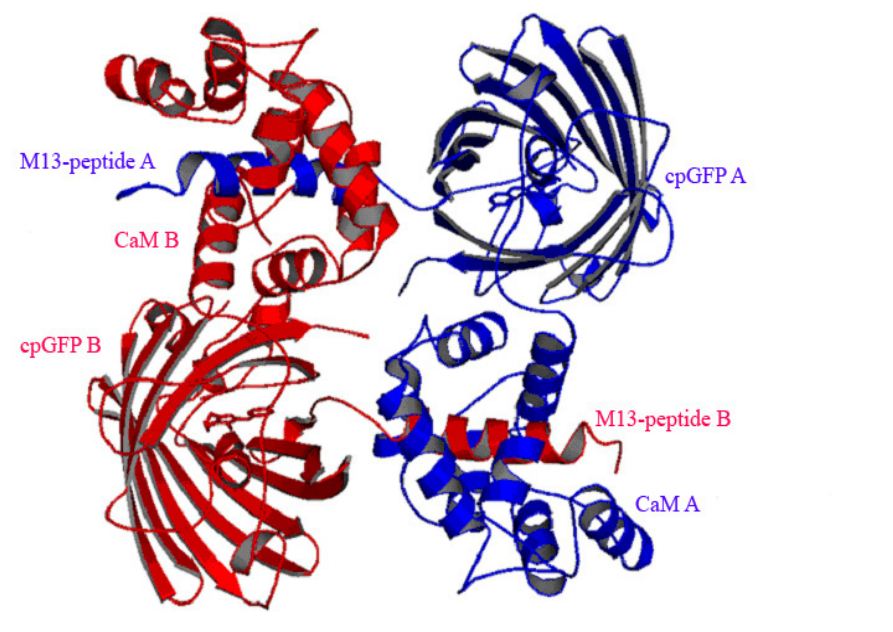
Figure 3. Ribbon diagram of Case12 structure B. Two Case12 (chains A and B are indicated in blue and red, respectively) that form intermolecular complexes between M13-peptide of chain A and CaM-domain of chain B (and vice versa ) are